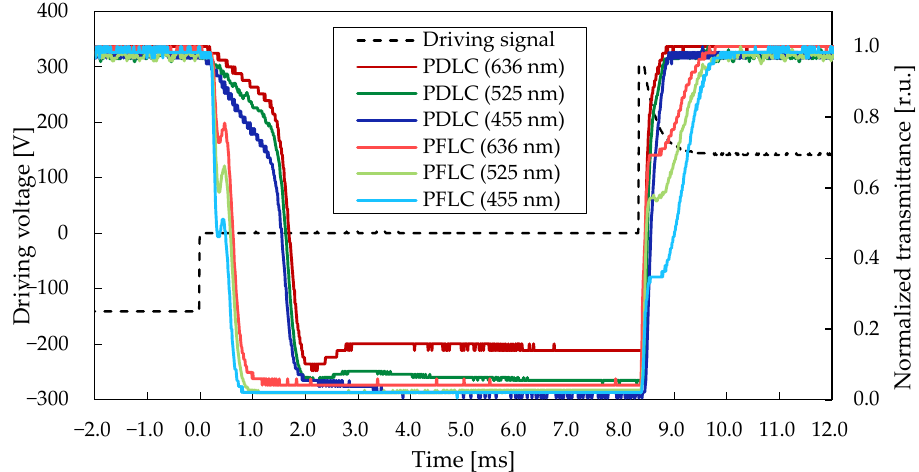
Figure 4. Dynamics of electrical and optical signals for PDLC and PFLC diffusers with a 15 μ m active LC layer. Measurements with 3-wavelength laser system.